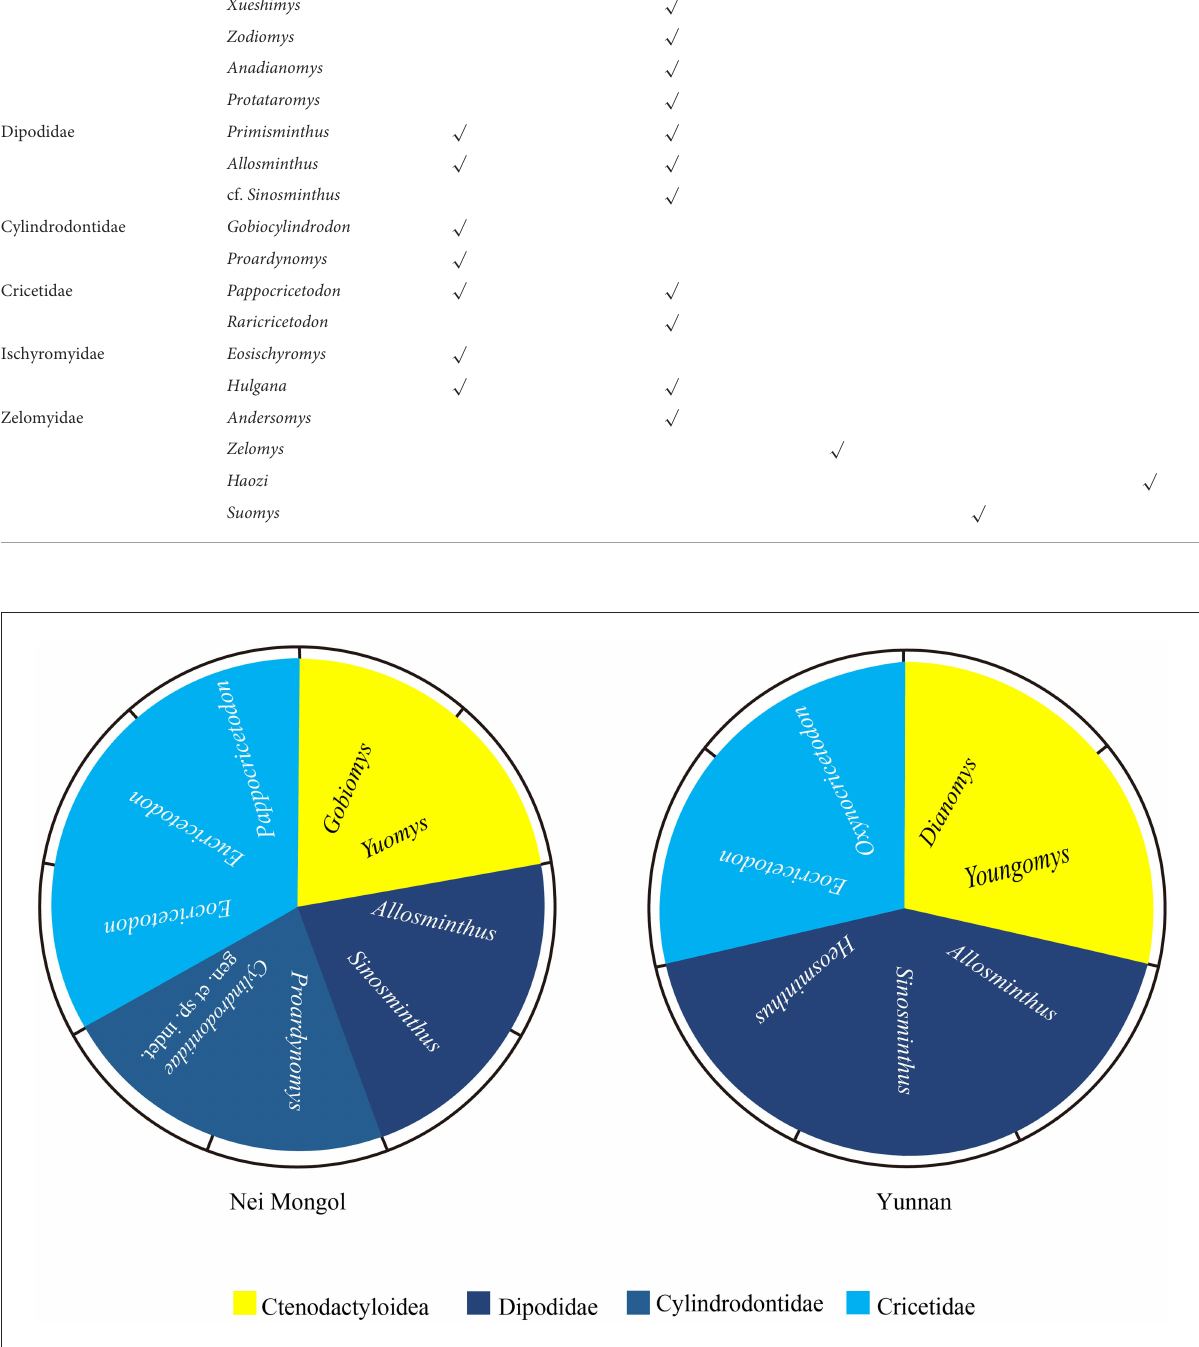
FIGURE5 Diagram of the Ulangochuian rodent compositions in Nei Mongol and Yunnan in